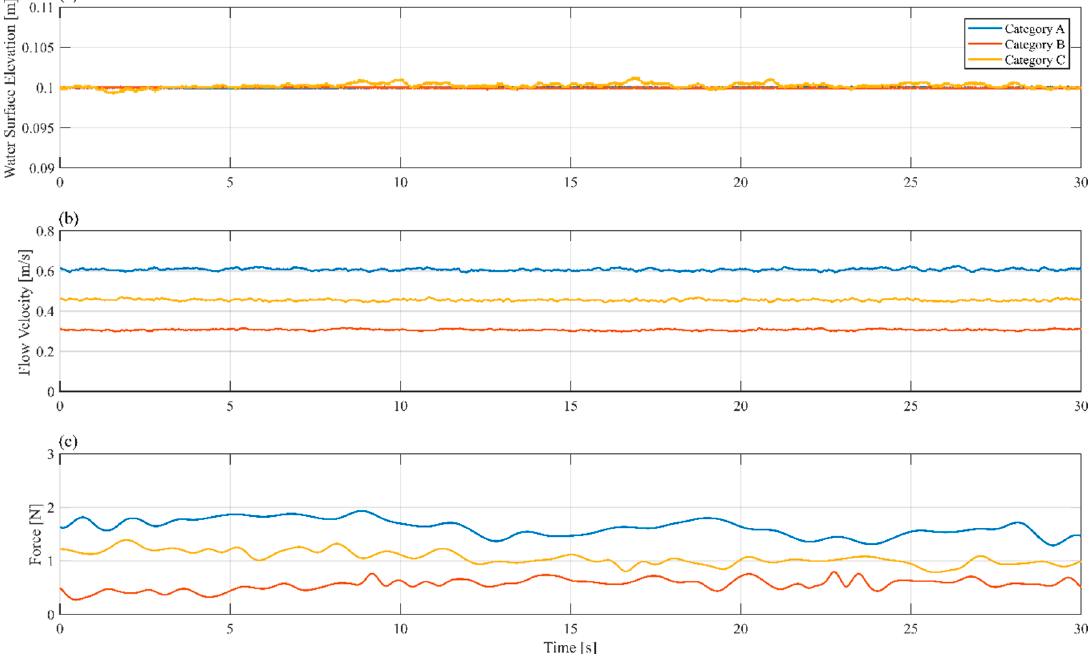
Figure 6. Hydrodynamic conditions in clear-water conditions for the three experimental categories listed in Table 3: ( a ) WG1 (x = 1.00 m); ( b ) ECM1 (x = 1.00 m); and ( c ) FT (x = 3.50 m).